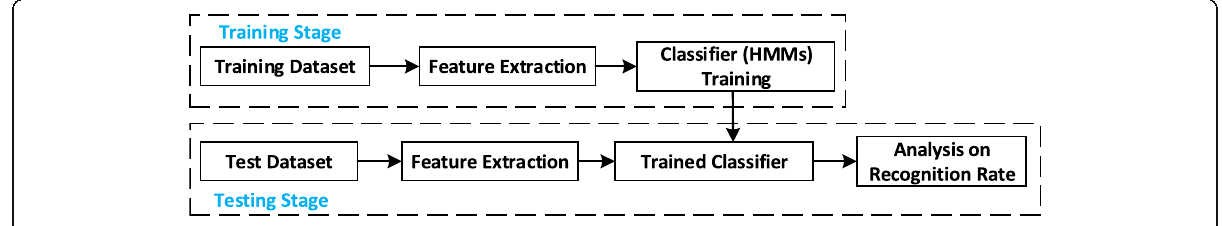
Fig. 12. Procedure for HMM-based drone-sound recognition